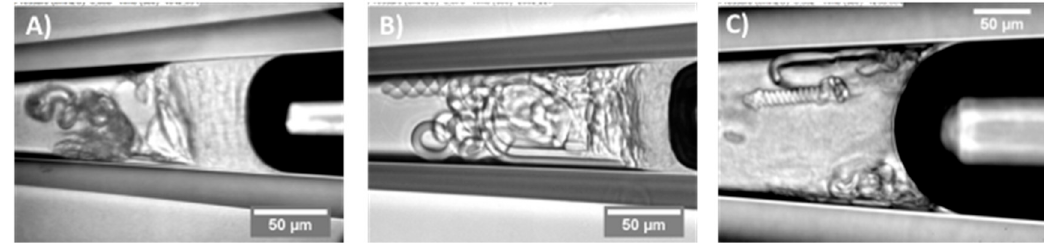
Figure 26. Video Micrographs showing presentative membrane structures observed in lipid ‐ Minisurf samples. ( A ) Stacked and collapsed membrane multilayer layers beneath the interface; ( B ) protrusions and tubules growing from the surface layers, ( C ) independent helical structures resulting from the coiling of membrane microtubes. Higher levels of material accumulation next to the interface led to an increased number of tubes and helixes developing towards the water side (see Supporting Information and videos [183]